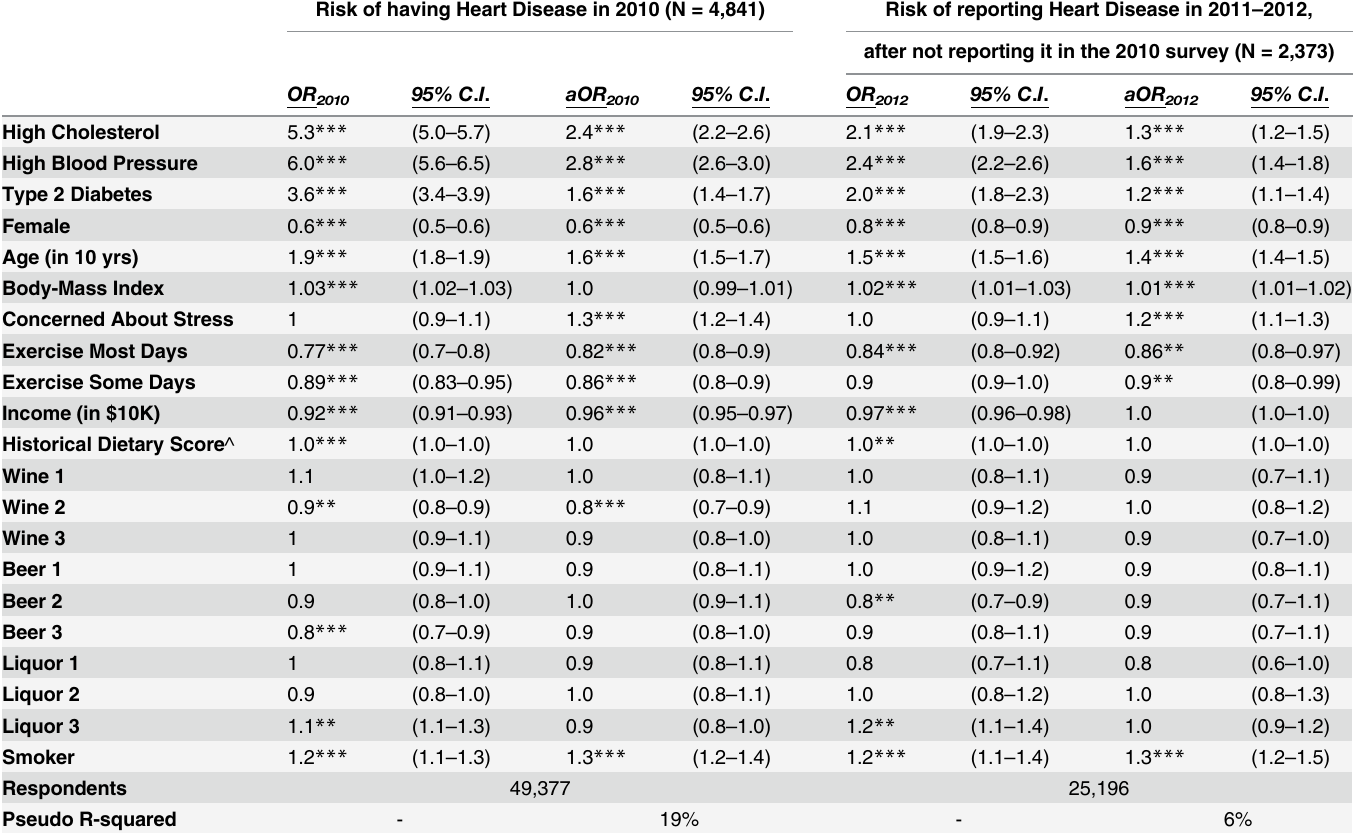
Table 2. Association between Sociodemographic, Health, and Lifestyle Factors with the Prevalence and Incidence of Heart Disease + , 2010 – 2012. Risk of having Heart Disease in 2010 (N = 4,841)